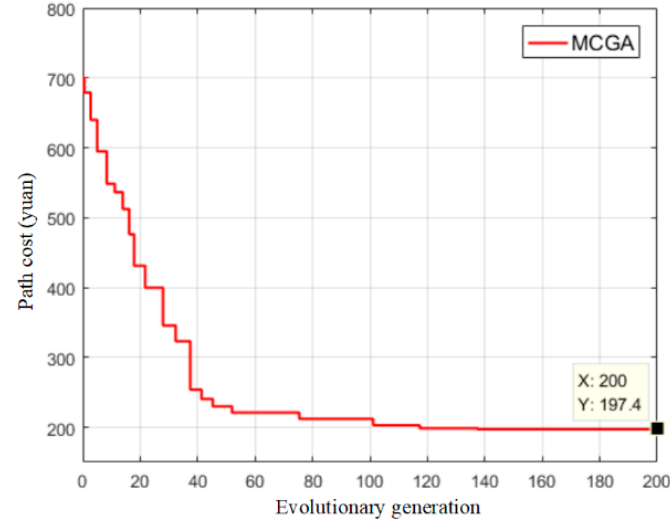
Figure 8. Cost trend chart of the initial scheduling scheme.